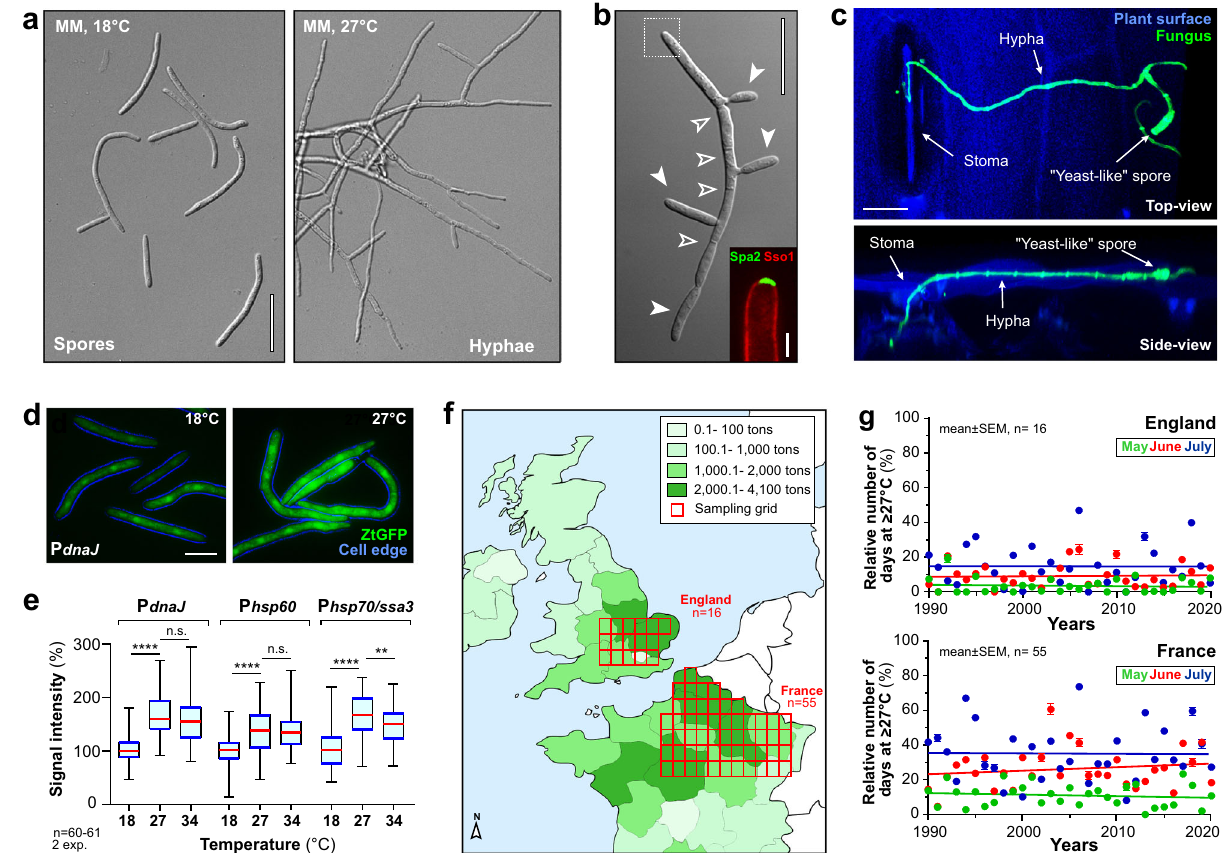
France.Colourcodingindicatesaverageyieldperyearintonsfrom2010to2014. Sampling areas, each approximately 2400km 2 , indicated in red. Yield data